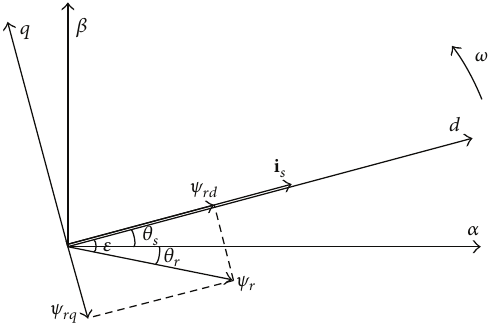
Figure 3: Stepping MMF of three-phase winding as 𝑏 𝐻 = 6 .